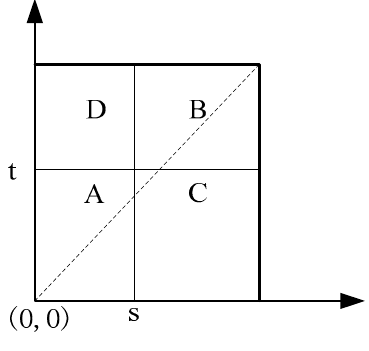
Figure 3. 2D histogram of reflectivity, region A represents the target, region B is the background, and regions C and D are away from the diagonal.